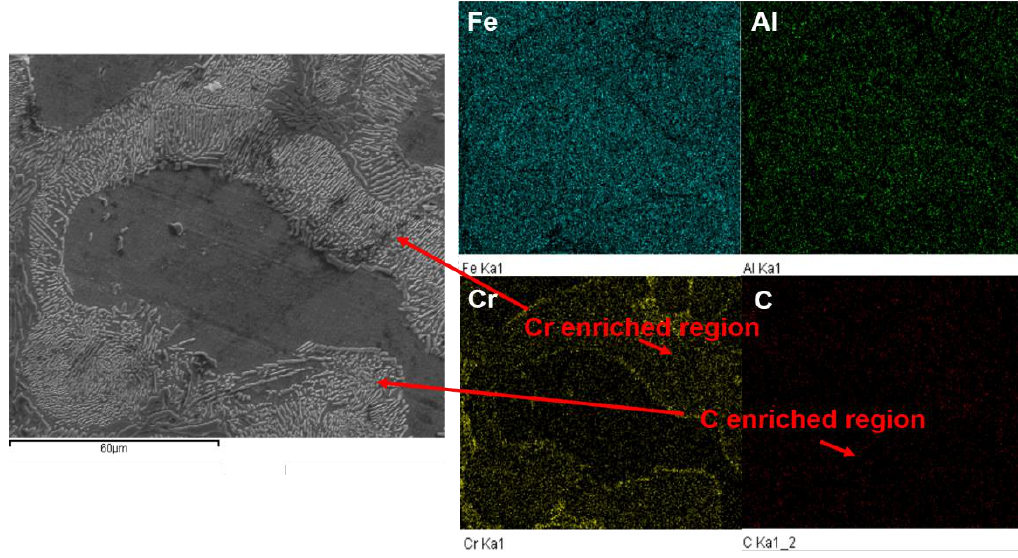
Figure 4. FESEM image of alloy #2 sample grain and element distribution at a grain boundary. The distribution of Cr elements coincides with that of the phases in the grain boundary.